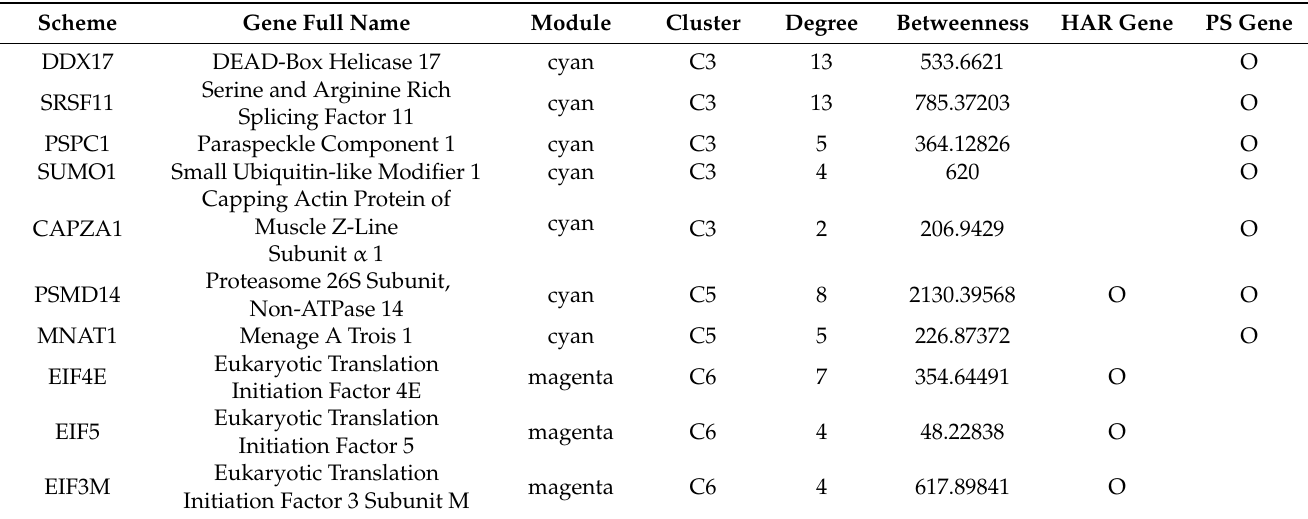
Table 2. HAR genes and PS genes detected in the cyan module C3 and C5 clusters and the magenta module C6